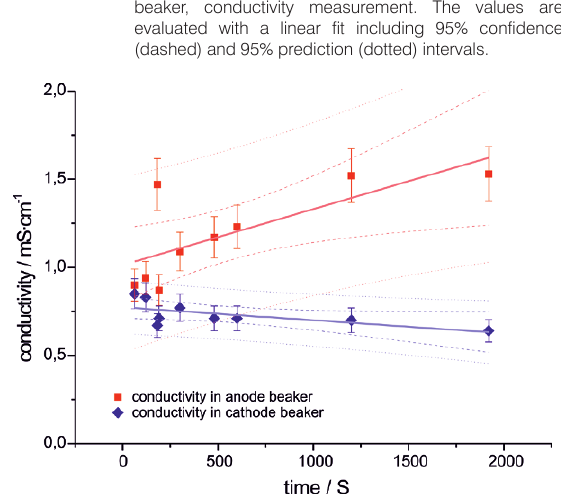
Figure 10. Exp. 2b: Transport of phenol from anodic to cathode beaker, conductivity measurement. The values are evaluated with a linear fit including 95% confidence (dashed) and 95% prediction (dotted) intervals.